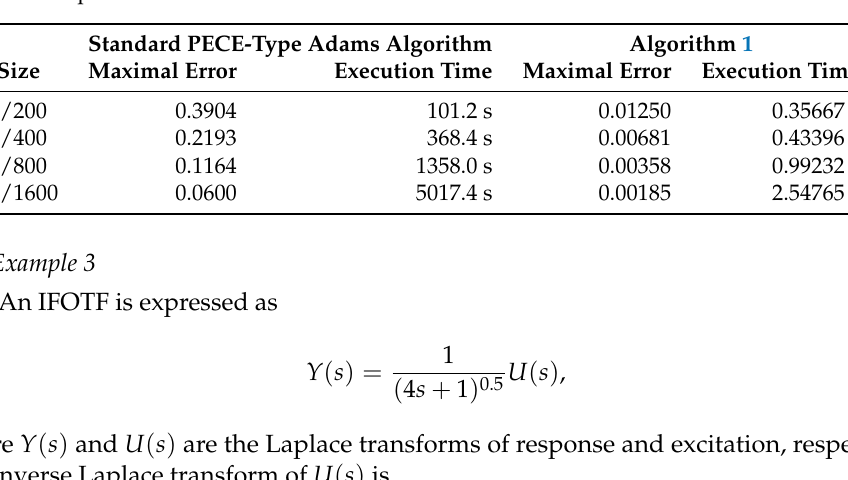
Table 2. Comparison of the errors and the execution times.